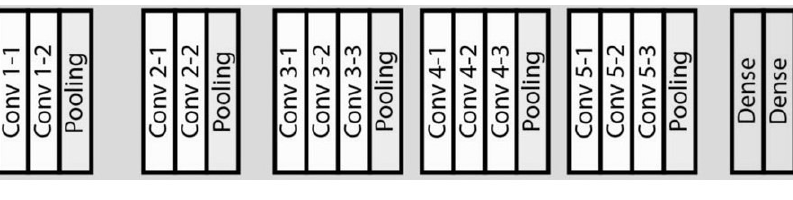
Figure 4. The details of the VGG-16 backbone model [27] used in the proposed